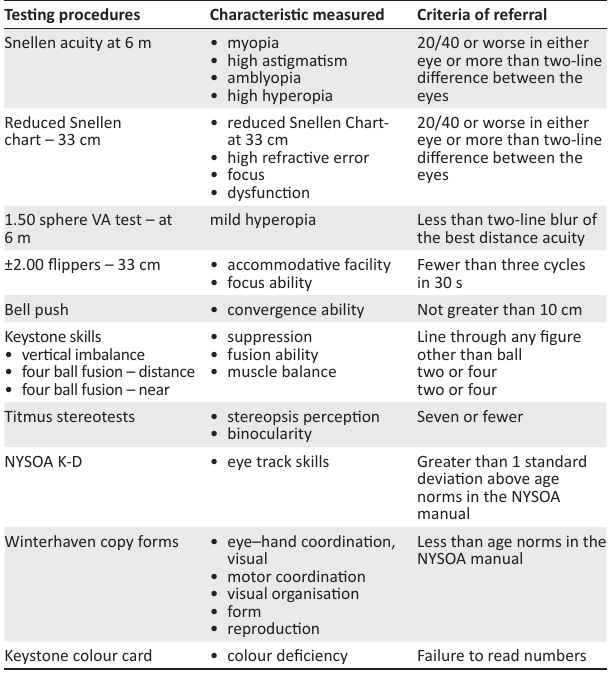
TABLE 2: Clinical procedures and referral criteria for the New York State Optometric Association screening